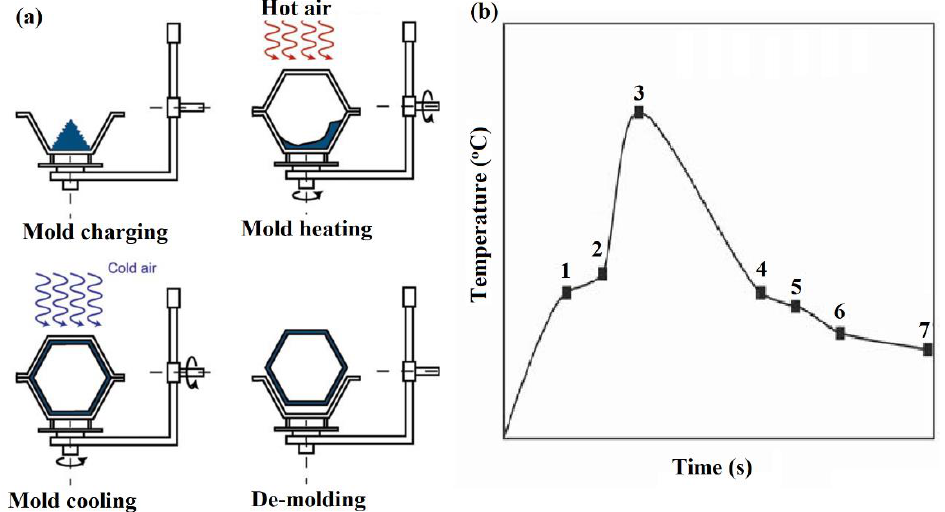
Figure 11. ( a ) Rotomolding process and ( b ) thermal cycle for rotomolding of a semi-crystalline polymer [141]. There are seven steps in the thermal cycle profile.